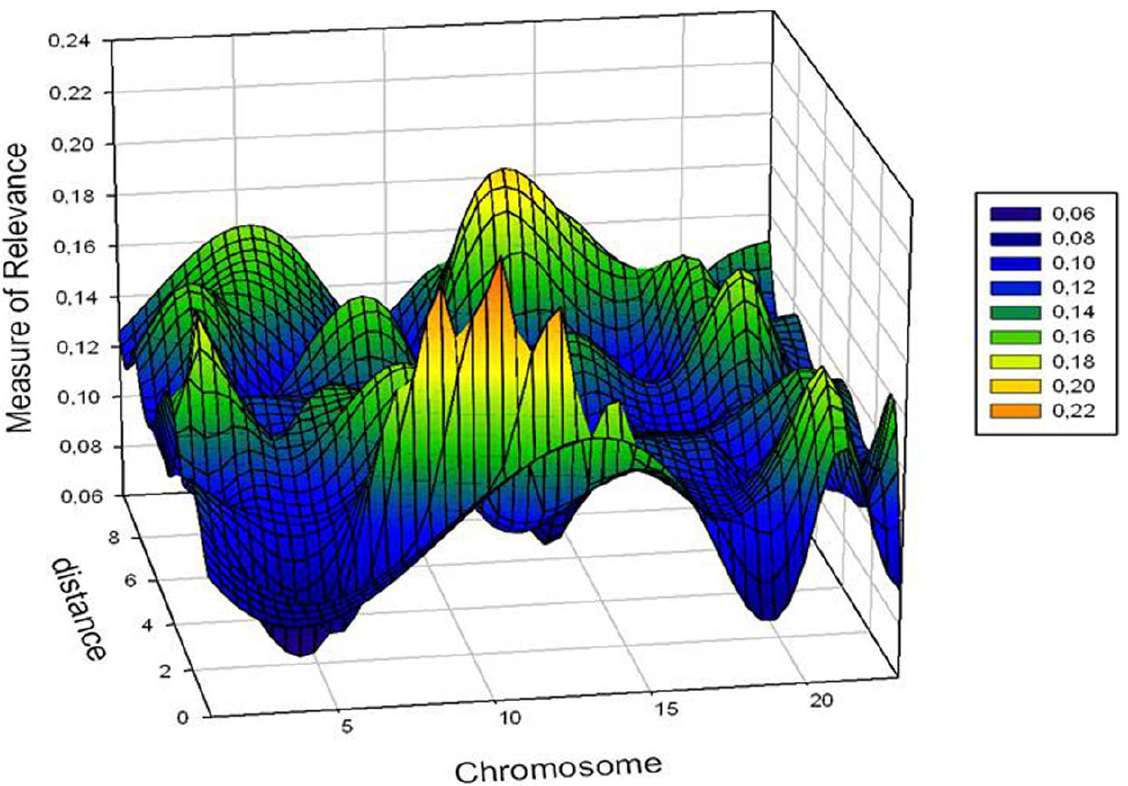
Figure 4. Mountain-valley view of the MoR-values corresponding to the most informative SNPs. Identifying genes with relevant differences in microarray-based expressions between HAB, NAB and LAB mice. Using the MoR method with the entropy-based stop criterion for variable selection 29 , 30 and 28 among 46,657 probes were proven to be very informative (relevant) in their expression profiles between HAB and NAB (black symbols over the black solid line), HAB and LAB (blue symbols over the blue solid line)and NAB and LAB (red symbols over the red solid line) mice, respectively. All relevant probes belong to the set of the 32 genes identified and declared with laborious methods from the study investigators as top candidate genes for further